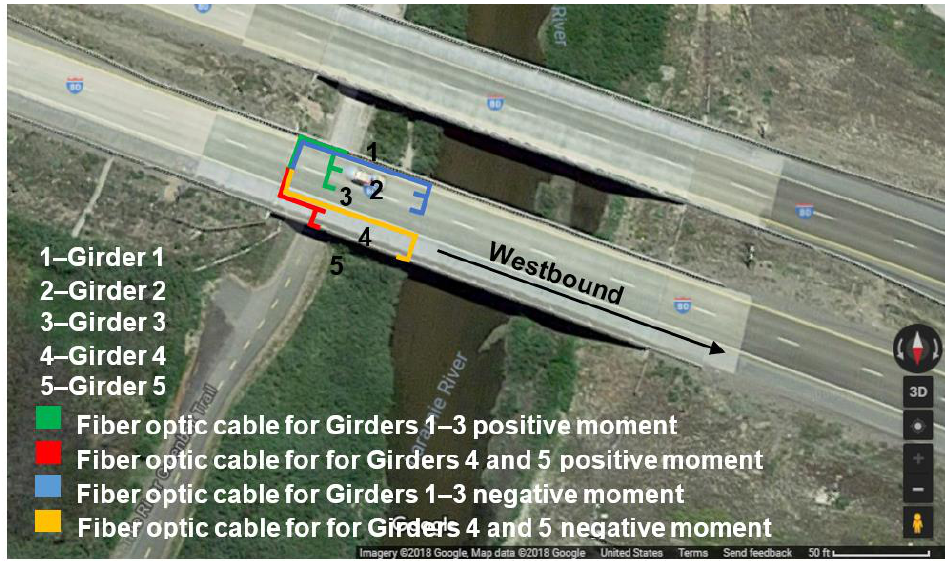
Figure 4. Fiber optic system for the bridge with the web-and-flange array.